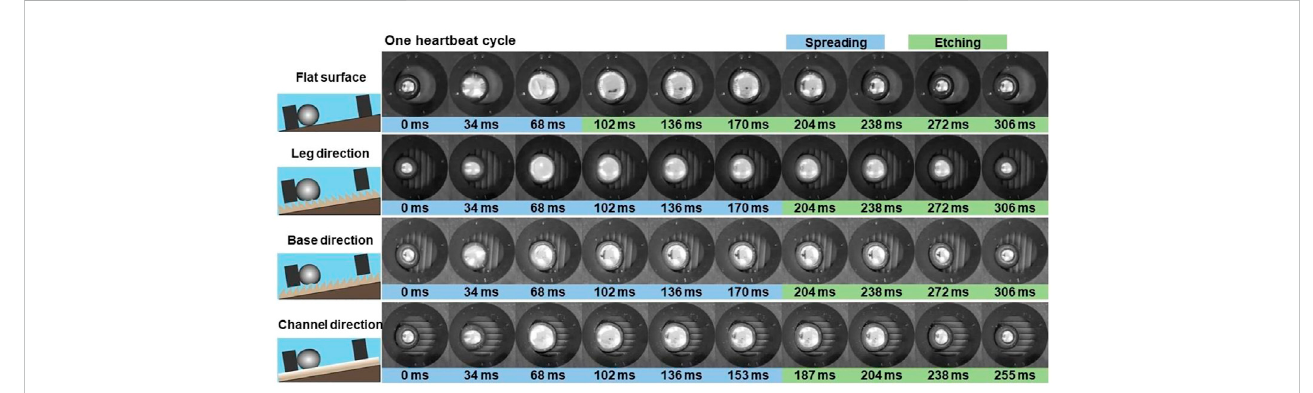
12 V DC voltage in a 1.5 mol/L NaOH solution. The eGaIn drops are spherical on both smooth and ratchet substrates, as shown in Figure 4A – F. After applying the voltage, the drops deform suddenly and become fl at on the smooth surface, the same as previously reported. For the eGaIn drop on the ratchet substrate, it not only spreads in a long strip but also sinks into the grooves of the sawtooth structure. Obviously, the spread width of the eGaIn drop on the ratchet substrate is narrower than that on the smooth surface.